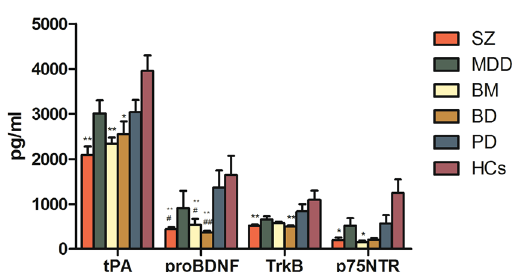
There was a positive correlation between TrkB and PDSS scores ( r = 0.393, P = 0.035), and between BDNF/ proBDNF value and age ( r = 0.406, P = 0.032), and a negative association between p75NTR and BMI ( r = − 0.546, P = 0.005) and the value of BDNF/proBDNF and education ( r = − 0.391, P = 0.040) in PD patients.